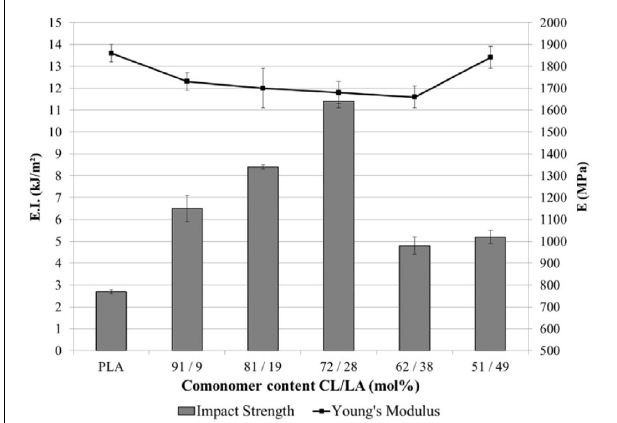
FIGURE 3 | Influence of the LA comonomer content of copolyester on the notched Izod impact strength and Young’s modulus of PLA-based materials containing 10wt.% of P[CL- co -LA]. [Reprinted from Odent et al. (2013b) with permission from